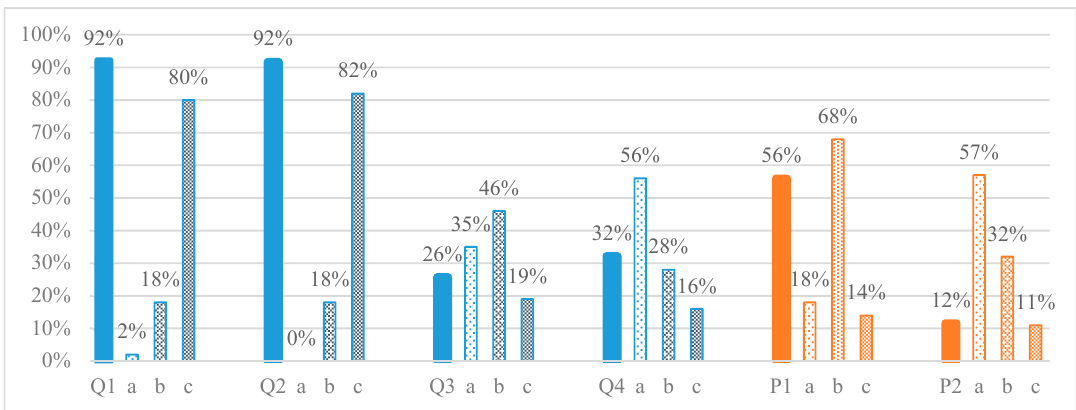
Figure 2. The evaluation of the difficulty of the problems in the assessment test (background fill color) and the students’ self-assessment from question S1 (shaded columns).